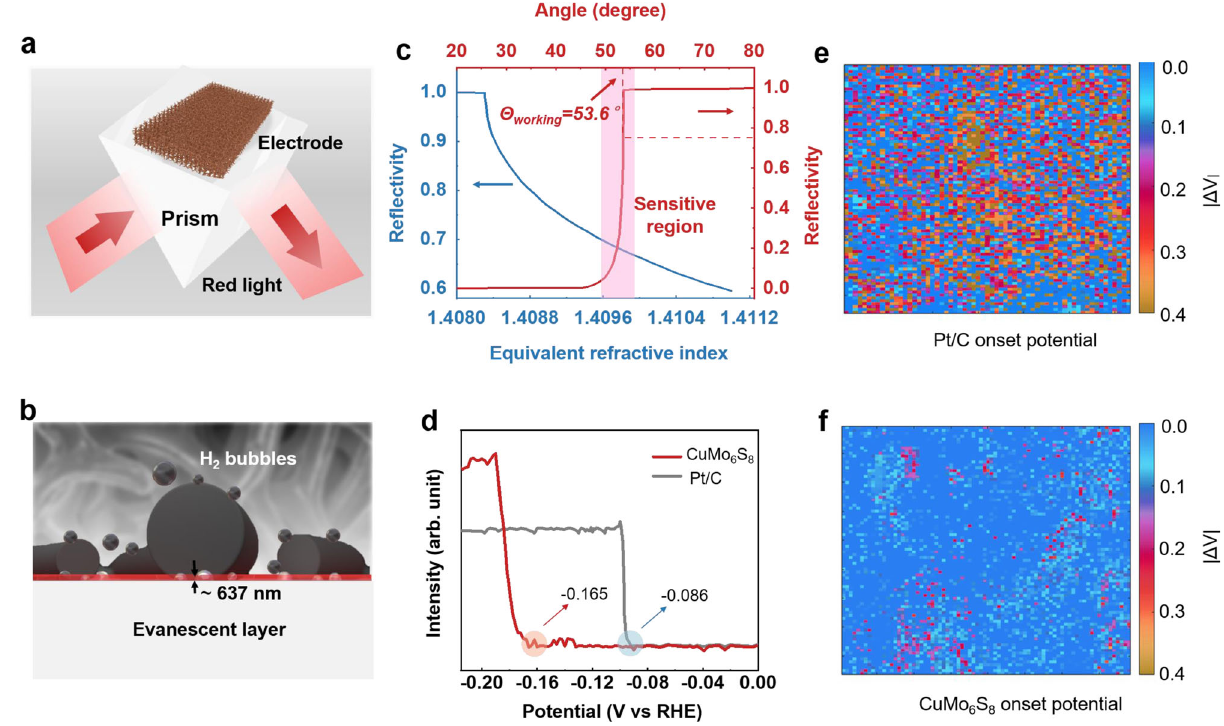
Fig. 3 | In-situ total internal re fl ection imaging method to characterize elec- trodestability.a Schematicofthemacroscopiccontactamongtheredlight,prism and electrode. The incident red light is at the TIR angle. b The new-born micro- scopic interfaces between the electrode, H 2 bubbles, and electrolyte during HER. The evanescent layer is about 637nm. c The relationships between incident angle,